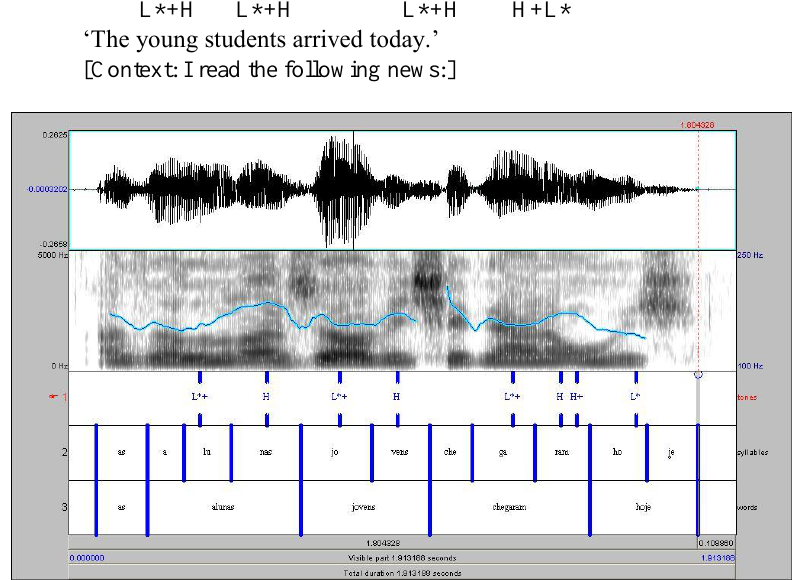
Figure 1. F 0 contour of the neutral sentence As alunas jovens chegaram hoje ‘The young students arrived today’ produced by F in neutral